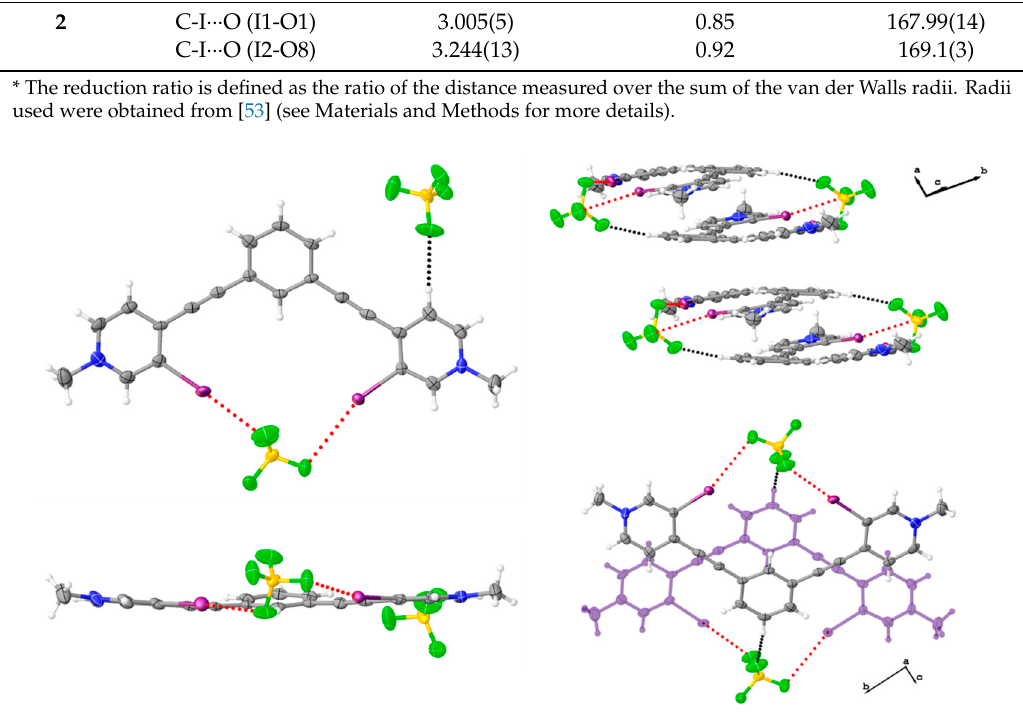
Figure 1. Asymmetric unit of 1 highlighting the bidentate conformation, the halogen bonds (red dotted lines) to the tetrafluoroborate anion, and the C-H hydrogen bonding (black dotted lines) to the tetrafluoroborate anion outside the pocket ( upper and lower left ). The upper left image shows a top down view while the bottom left image is from the side, highlighting the distortion of the receptor and the halogen bonds to the different fluorine atoms. On the upper right, the packing diagram highlights the dimers formed between two receptors, which result in columns that propagate along the crystallographic a axis. The lower right image highlights the centered antiparallel dimer. Thermal ellipsoids are drawn at the 50% probability level and anion disorder is omitted for clarity.